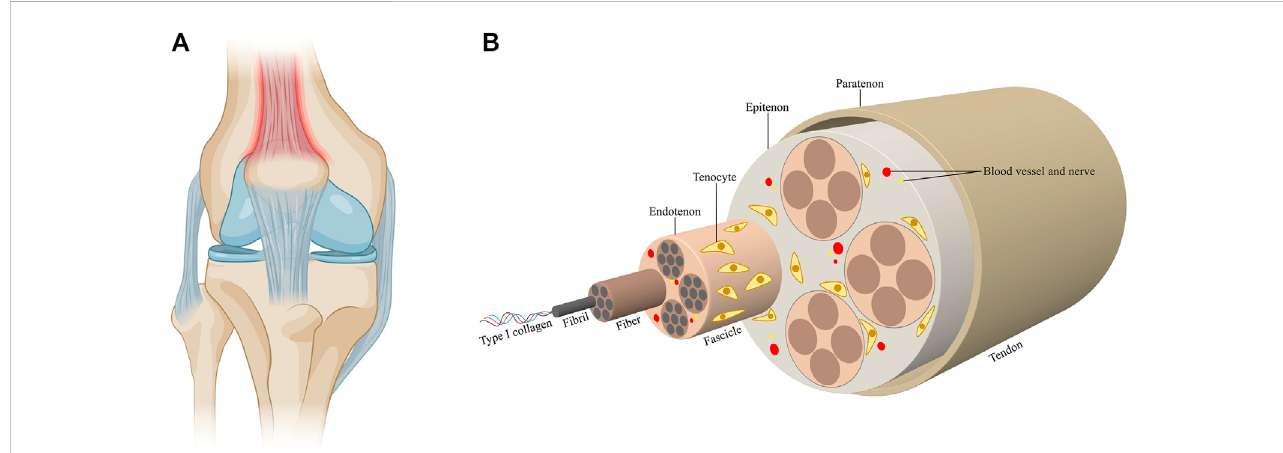
FIGURE 1 Tendon structure and composition. (A) Tendons are connective tissues that connect muscle to bone. (B) Triple-helical type I collagen molecules aggregate to form collagen fi brils, which further assemble into fascicles. The fascicles combine to form tendon tissues. Fibers are ensheathed by the endontenons, while the tendons are surrounded by the epitenon, which is further surrounded by the paratenon. Tenocytes sparsely align between the collagen fi bers. The blood vessels and nerves accompany the collagen fi bers in the